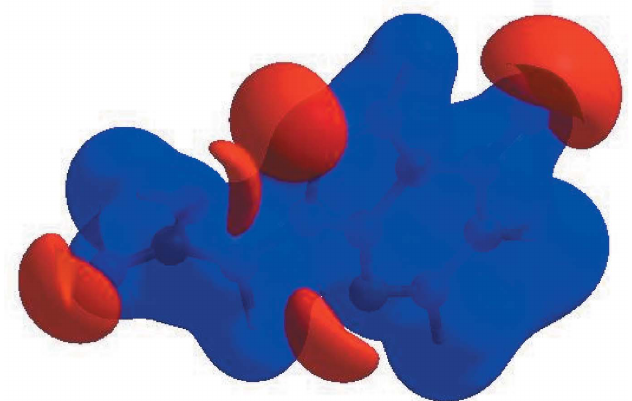
Figure 12 Contour surface of the electrostatic potential of (I).